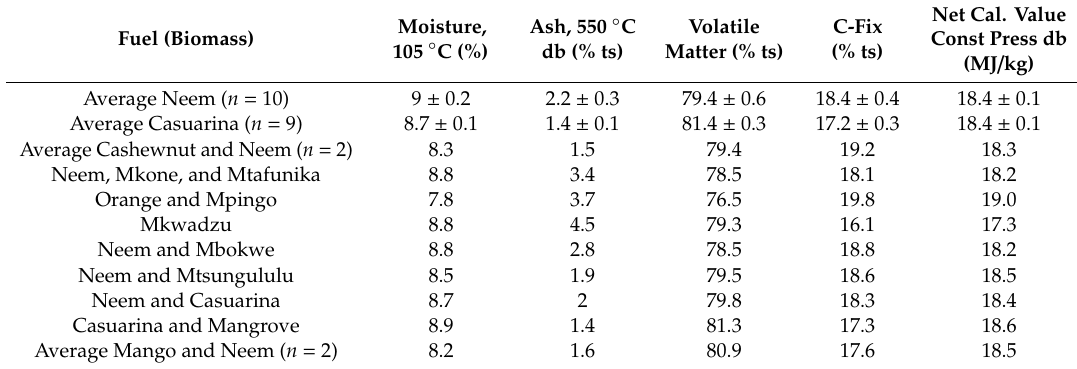
Table 2. Combustion properties of fuel used to cook. ts = total solids; db = dry